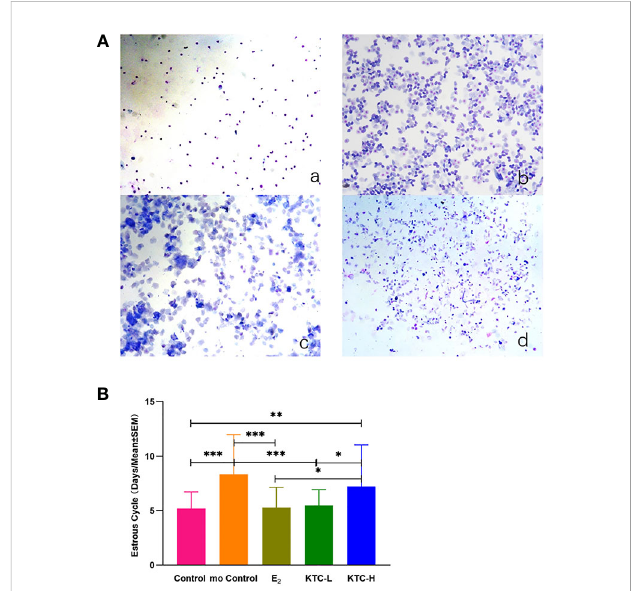
FIGURE 2 (A) The typical pictures of smears of vaginal cells at different stages of the estrous cycle in rats (×100). a Diestrus; b Proestrus; c Estrus; d Metestrus. (B) The estrous cycle in fi ve groups. * P <0.05; ** P <0.01; *** P